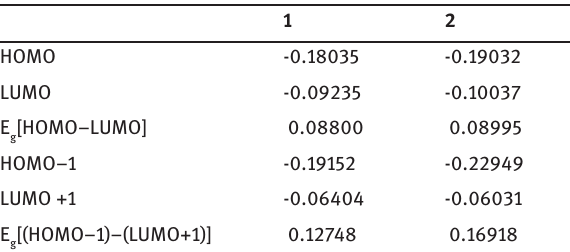
Table 4: Calculated HOMO-LUMO energy (a.u.) and HOMO-LUMO band gap )( E values for 1 - 2 . g